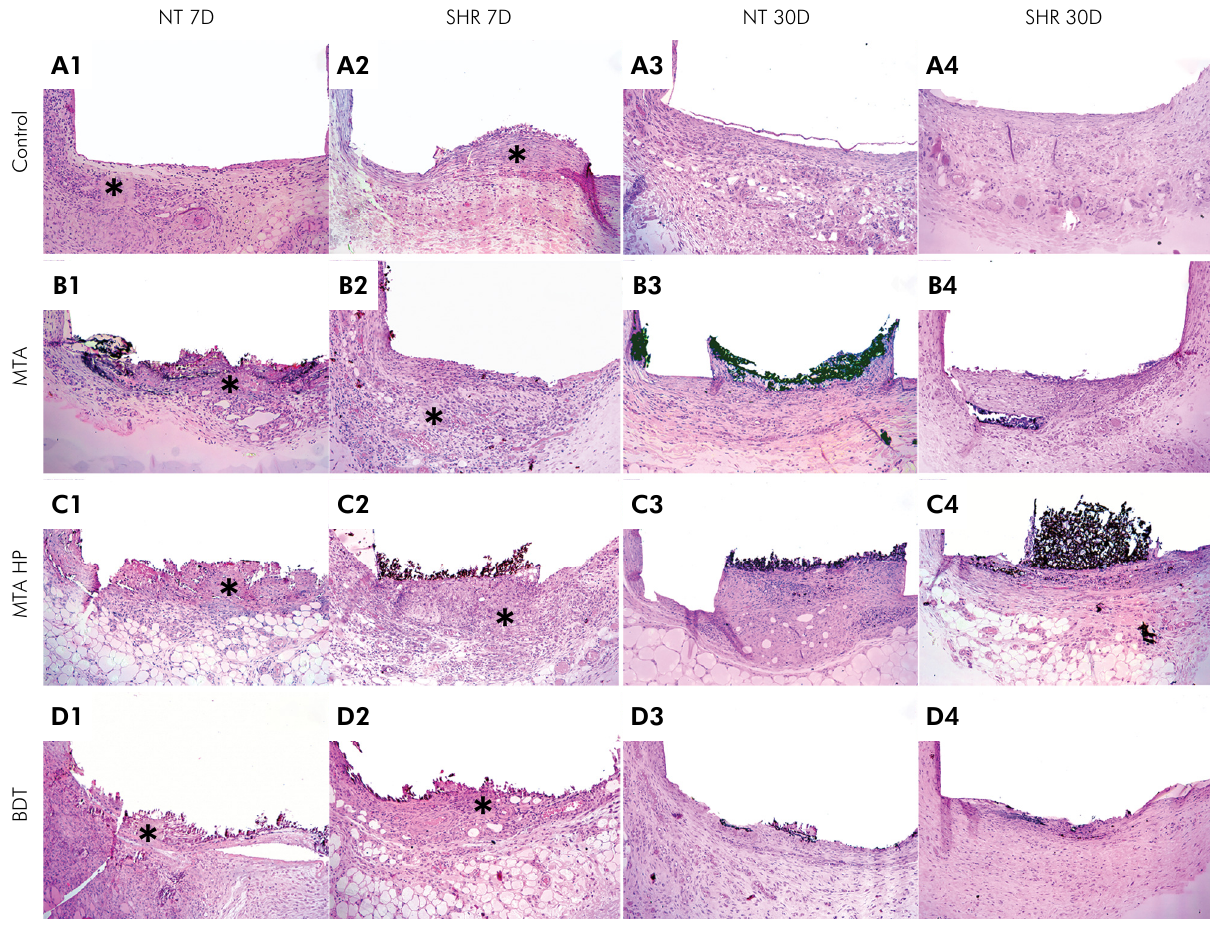
Figure 1. Representative images of inflammatory reaction in normotensive/hypertensive condition (NT/SHR), stained with hematoxylin-eosin. Fibrous capsule with greater density of inflammatory infiltrate (asterisk) (macrophages and lymphocytes) in the presence of MTA, MTA HP, and BDT under hypertensive conditions at 7 and 30 days (Scale bars: 200 μ m; Original magnification: 100×). *Mineral Trioxide Aggregate (MTA), High-plasticity MTA (MTA HP), and Biodentine®